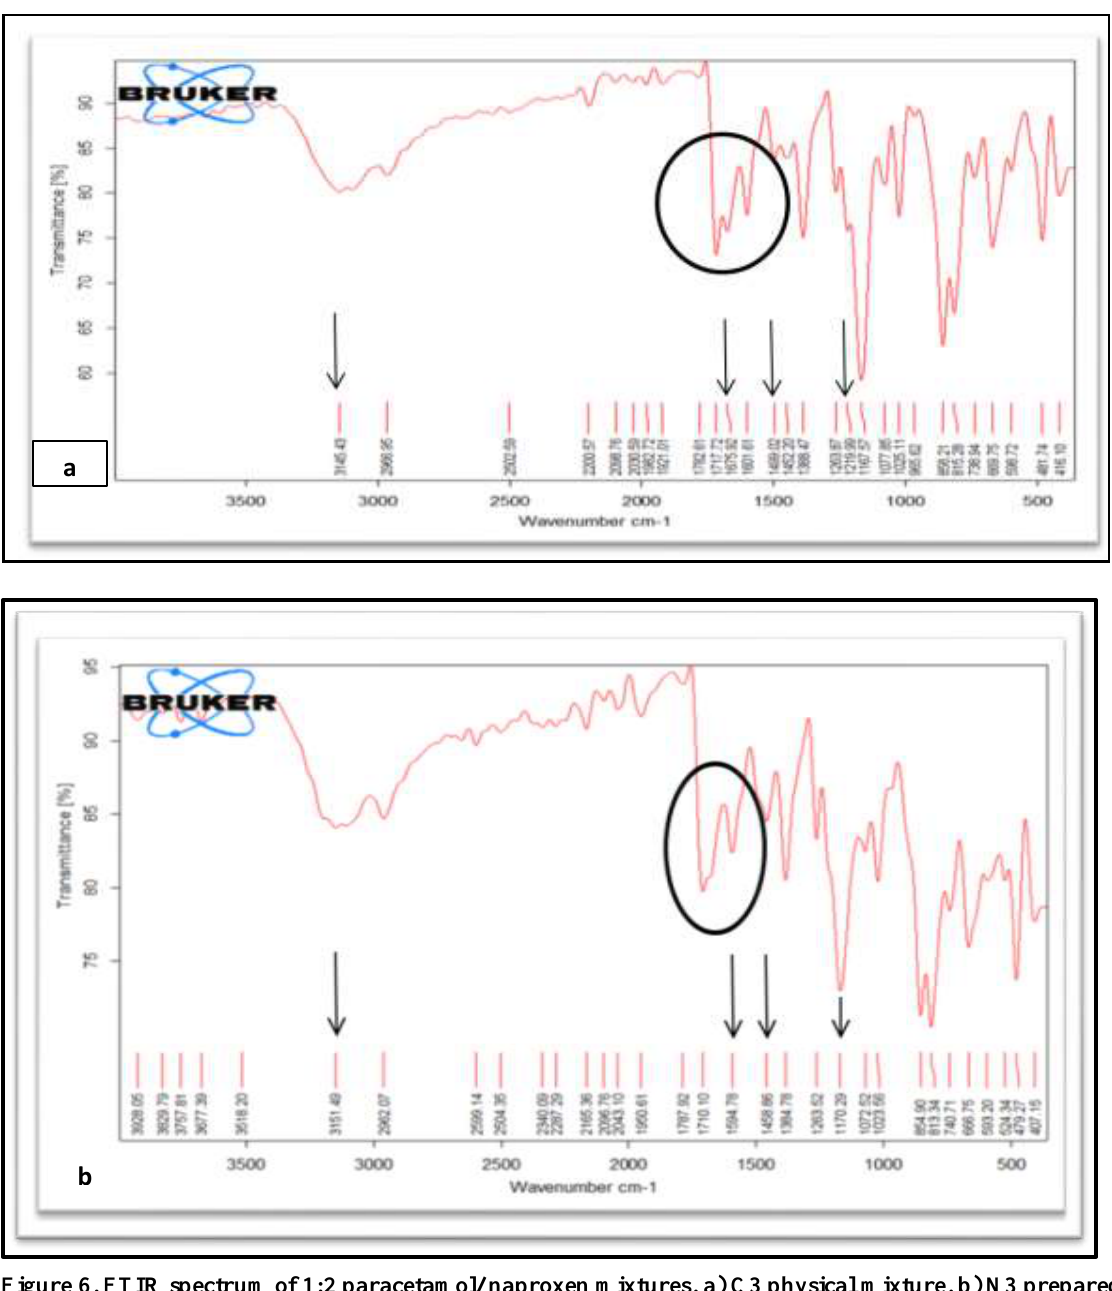
Figure 6. FTIR spectrum of 1:2 paracetamol/ naproxen mixtures. a) C3 physical mixture. b) N3 prepared co-crystal